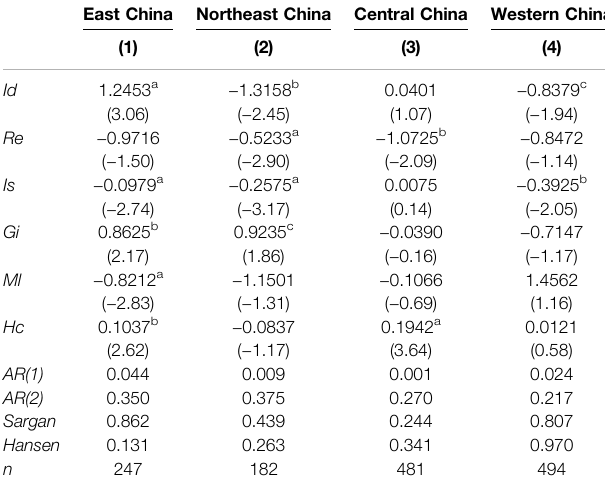
TABLE 6 | Robustness test results: replace be explained variable. TABLE 7 | Heterogeneity test results: different